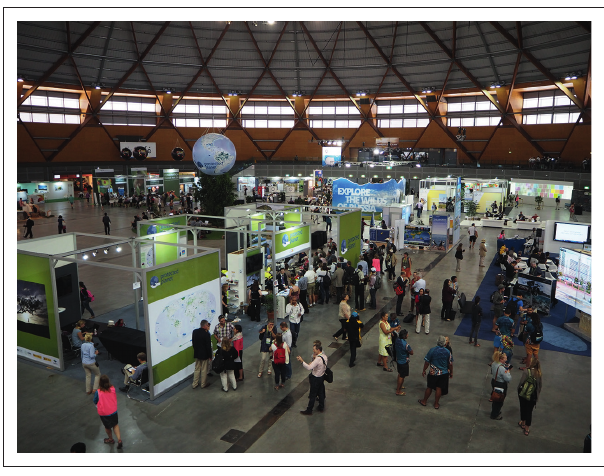
Source: Photograph taken by Ishbel Cullen FIGURE 1: Pavilions established at the International Union for Conservation of Nature World Parks Congress 2014.